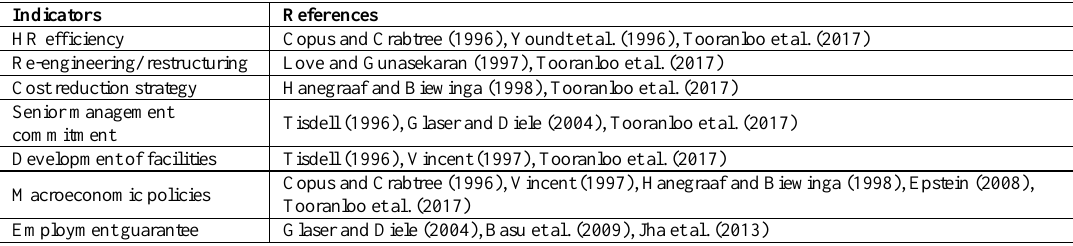
Table 5. Economic sustainability indicators of